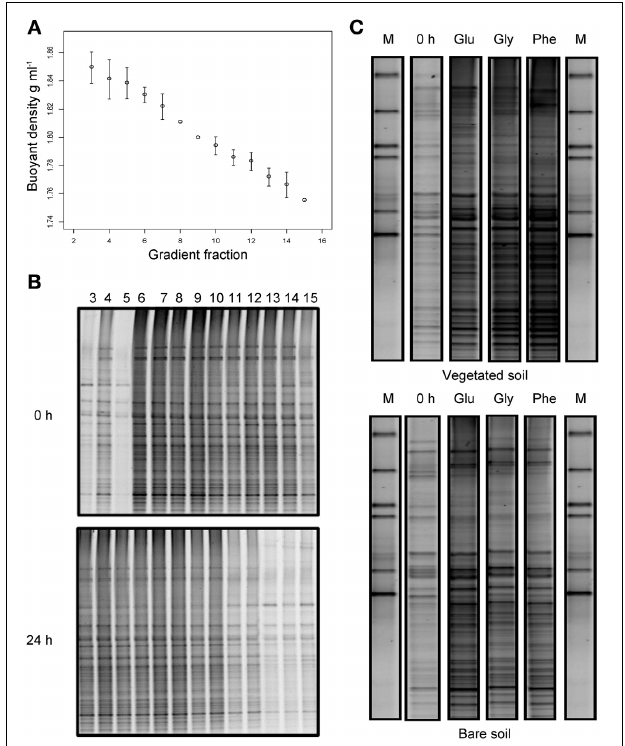
FIGURE 5 | Stable isotope probing of bacterial communities utilizing 13 C-labeled substrates. Buoyant density of extracted RNA in gradient fractions 3–15 following isopycnic density gradient centrifugation (A) . Error bars are standard deviations of the mean ( n = 4). DGGE profiles of bacterial communities present in density gradient fractions 3–15 from vegetated soils at time 0 and 24h after the addition of 13 C glucose (B) . Density gradient fractions 3–5 were shown to contain 13 C labeled RNA, as indicated by a general community shift into these fractions after labeled glucose addition. DGGE profiles of bacterial communities present in “heavy” density gradient fraction four from vegetated and bare soils, before and 24h after the addition of 13 C-labeled glucose (Glu), glycine (Gly), and phenol (Phe);M denotes marker lanes (C)